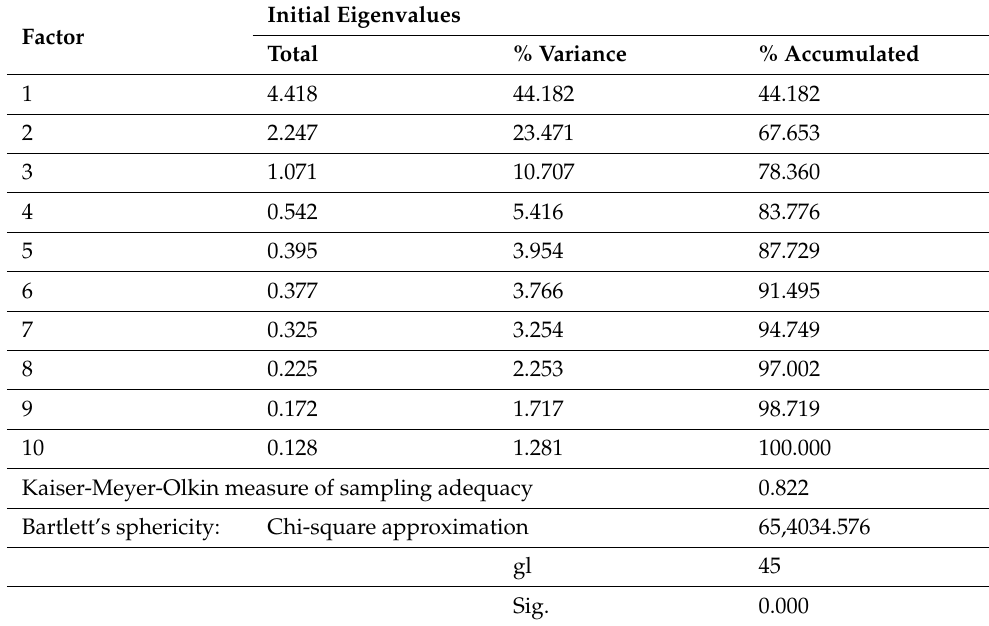
Table 4. Total explained variance and goodness-of-fit test in period